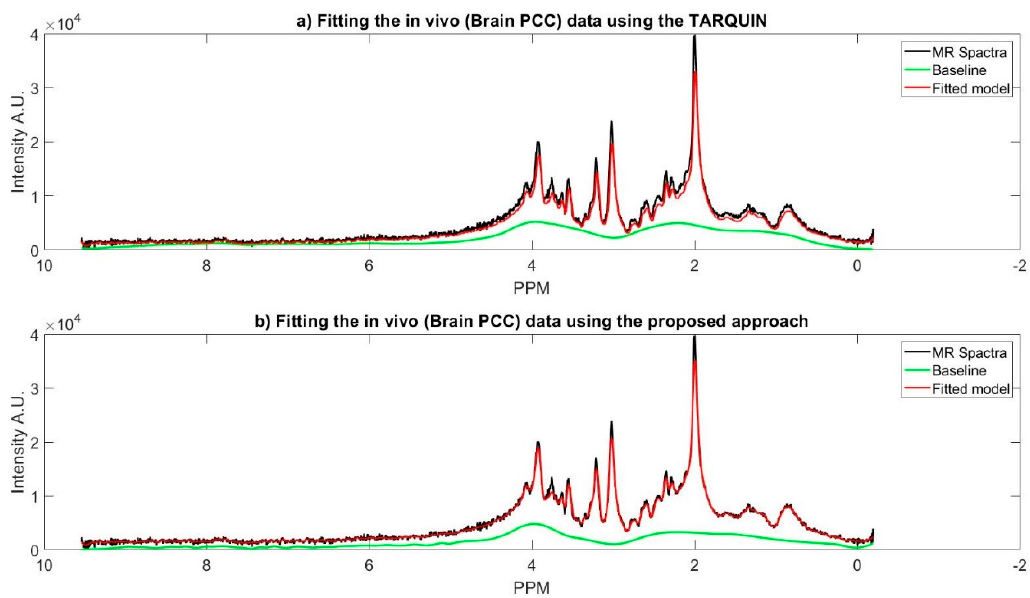
Figure 5. ( a ) The fitting in vivo data MR spectra using the TARQUIN; ( b ) the in vivo data MR spectra fitted using the proposed approach. For both figures, the phantom MR spectra (black), the fitted model (red), and the estimated baseline (green). Table 4. A comparison between in vivo metabolite concentration calculation in two brain regions (a) Posterior Cingulate Cortex (PCC) and (b)